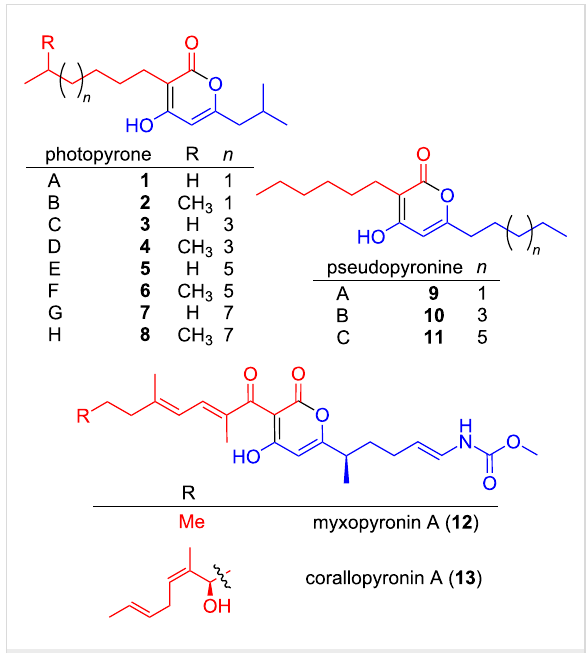
Figure 1: Structures of photopyrones 1–8 , pseudopyronines 9–11 , myxopyronin A ( 12 ) and corallopyronin A ( 13 ). For all α -pyrones the western (red) and the eastern (blue) acyl moiety is